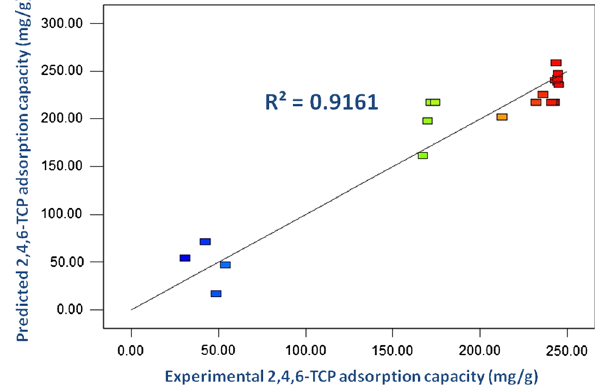
Table 3 ANOVA for response surface quadratic model of 2,4,6-TCP adsorption capacity by CSSS-AC